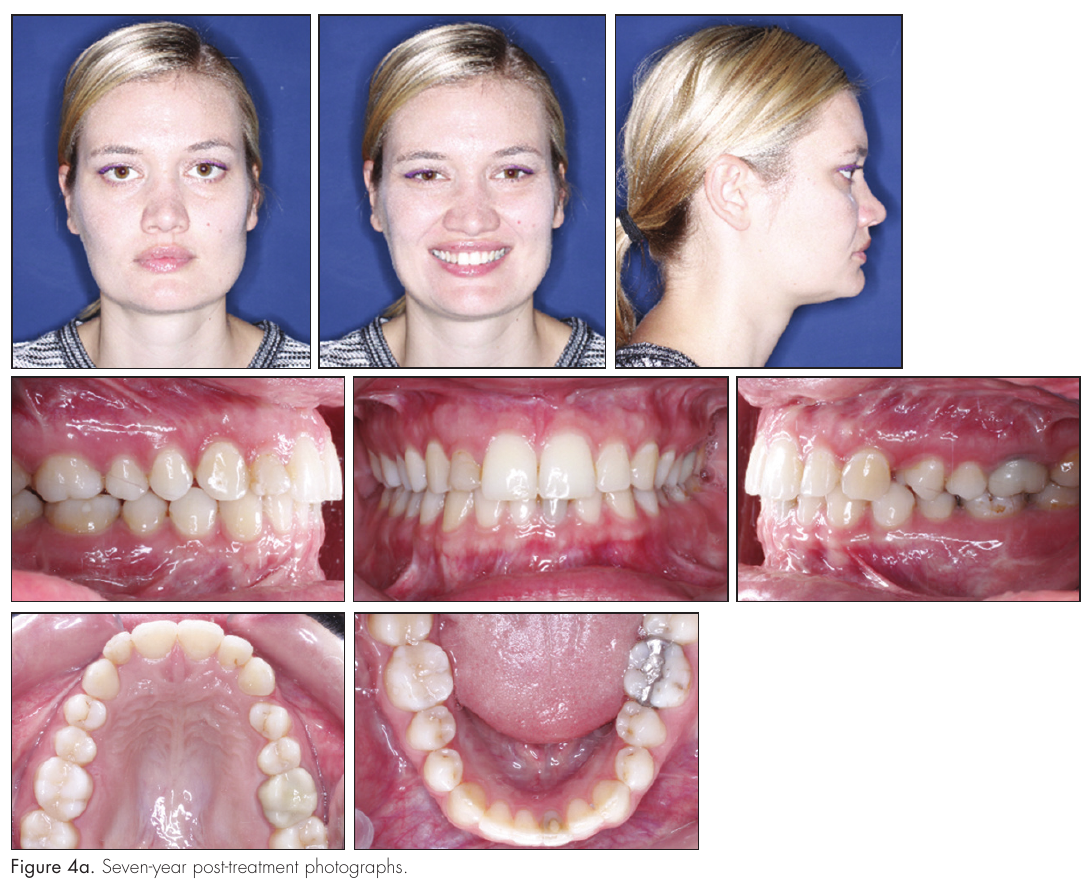
Figure 4a. Seven-year post-treatment photographs.